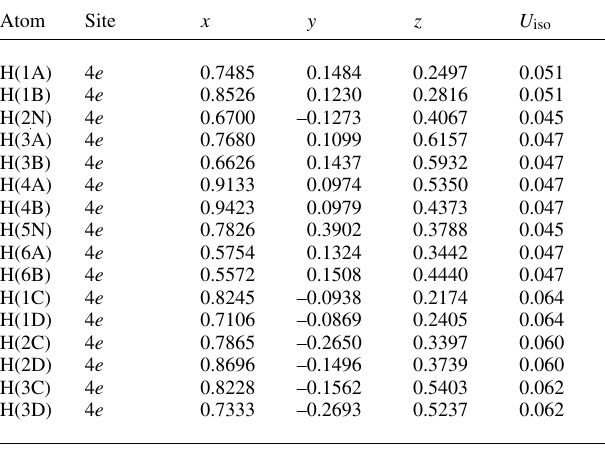
Table 2. Atomic coordinates and displacement parameters (in Å 2 )